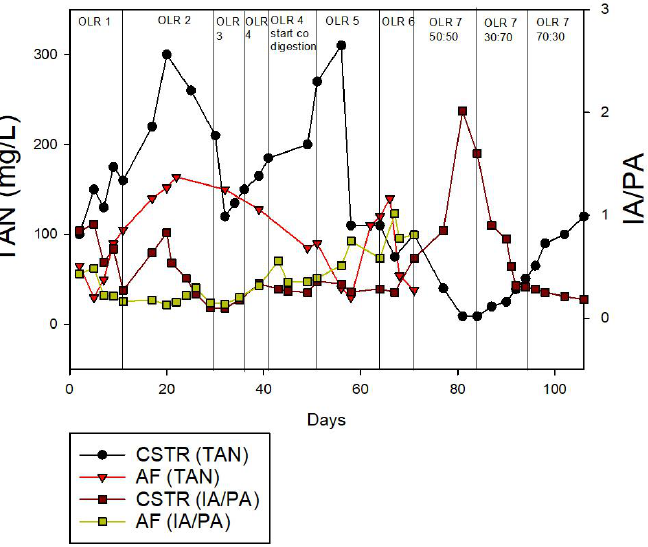
Figure 8. Total ammonia nitrogen (TAN) and total alkalinity ratio (IA/PA) for continuous